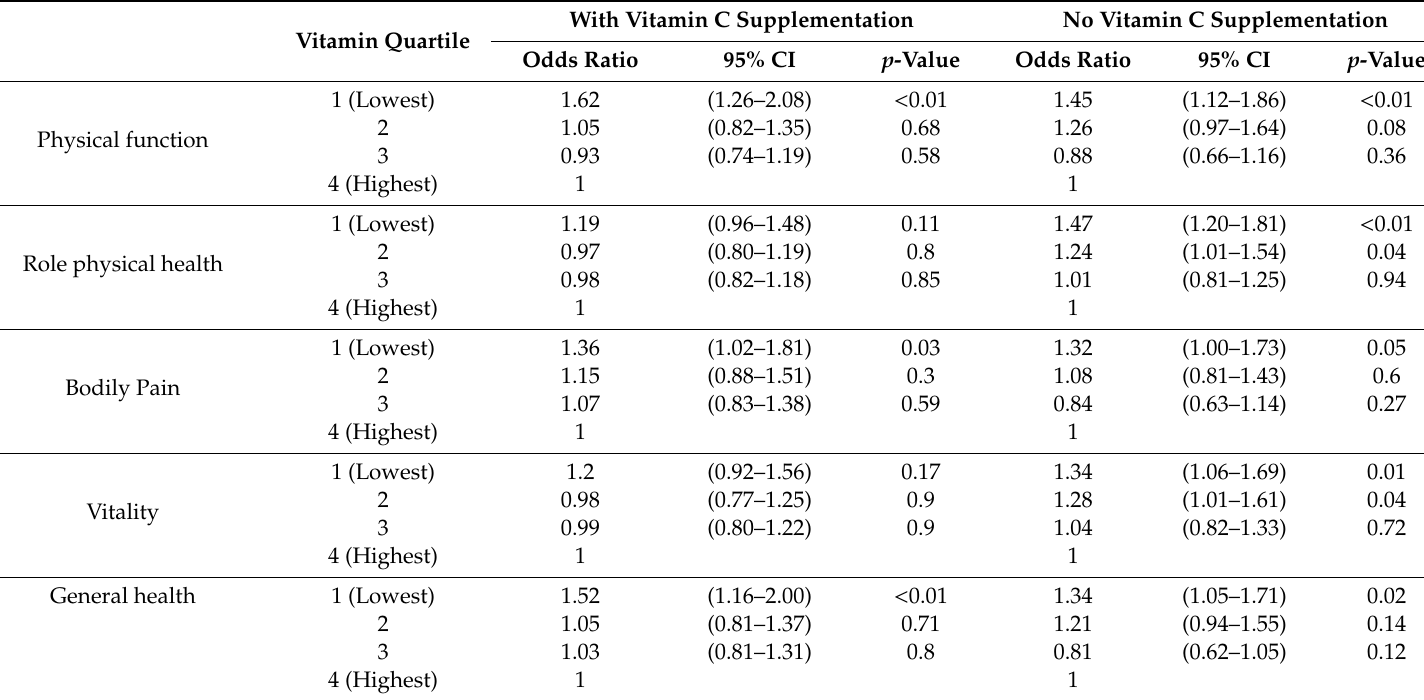
Table 4. Association between plasma vitamin C quartile and SF-36 domain (physical function and vitality) stratified by supplementation of vitamin